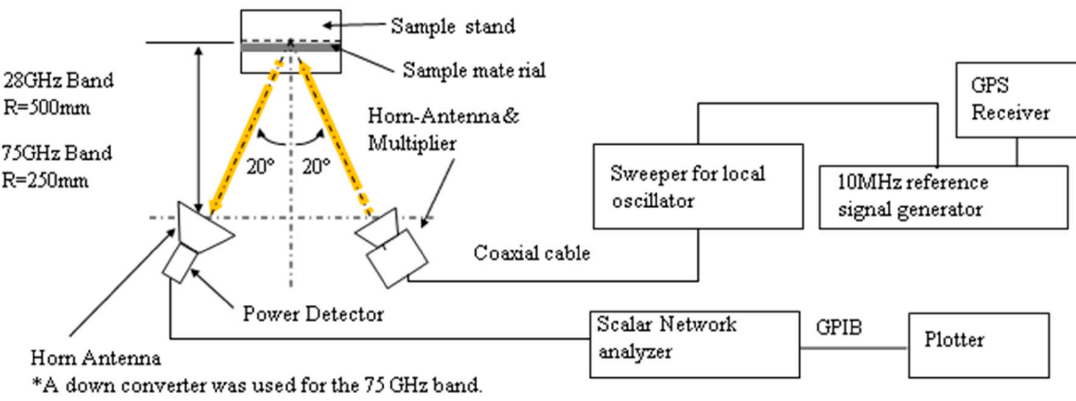
Figure 5. Outline of the radio wave absorption verification system.